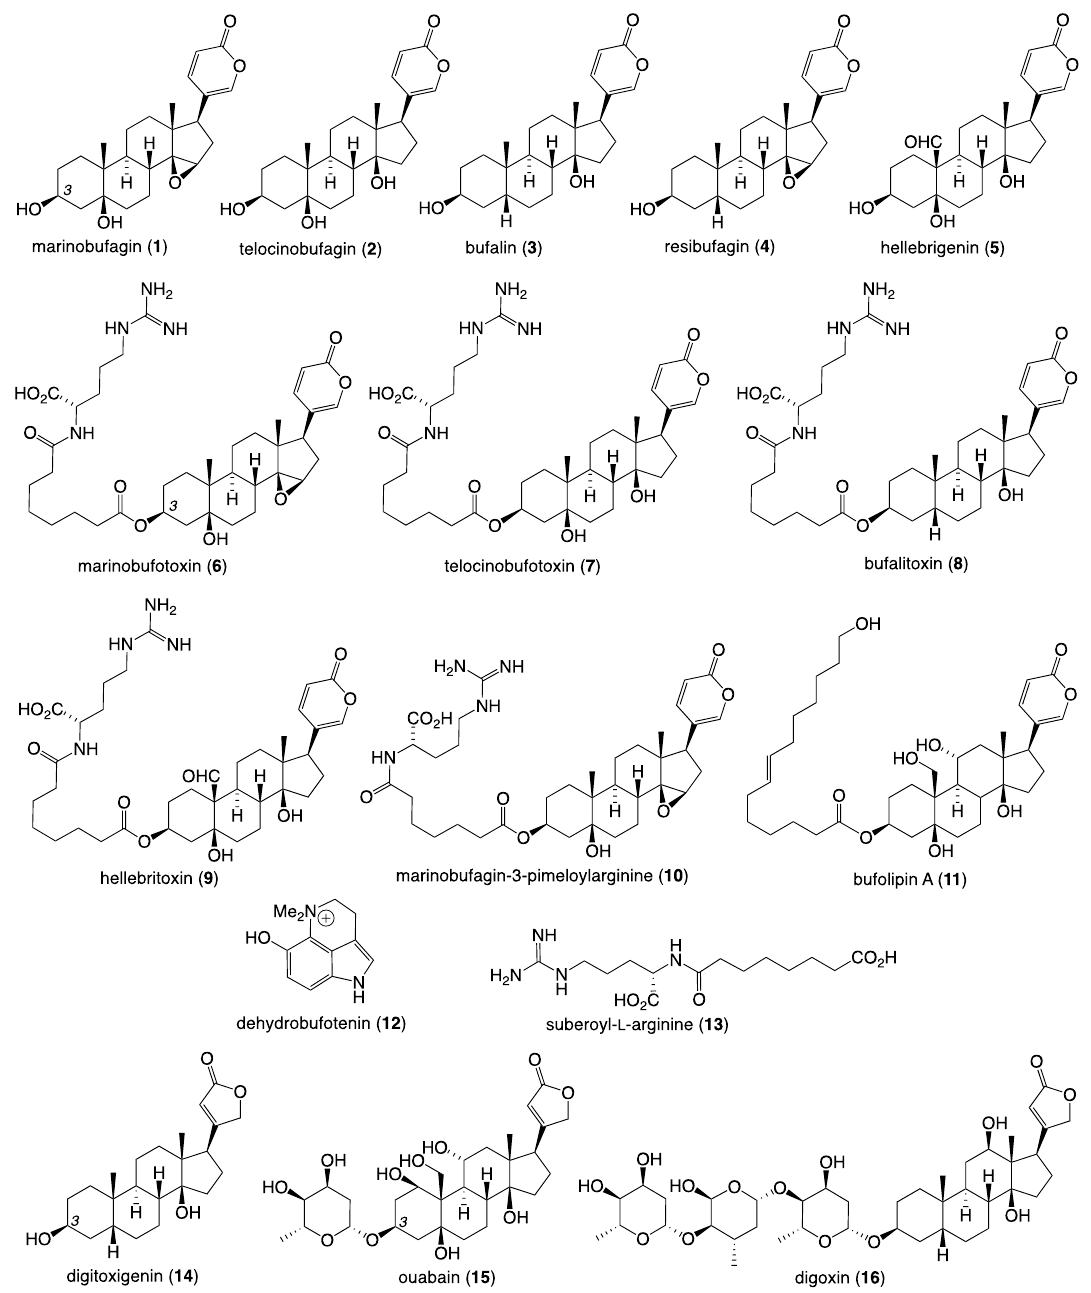
Figure 2. Compounds identified in different stages of cane toad ( Rhinella marina ) ( 1 – 13 ) and plant derived cardenolides ( 14 – 16